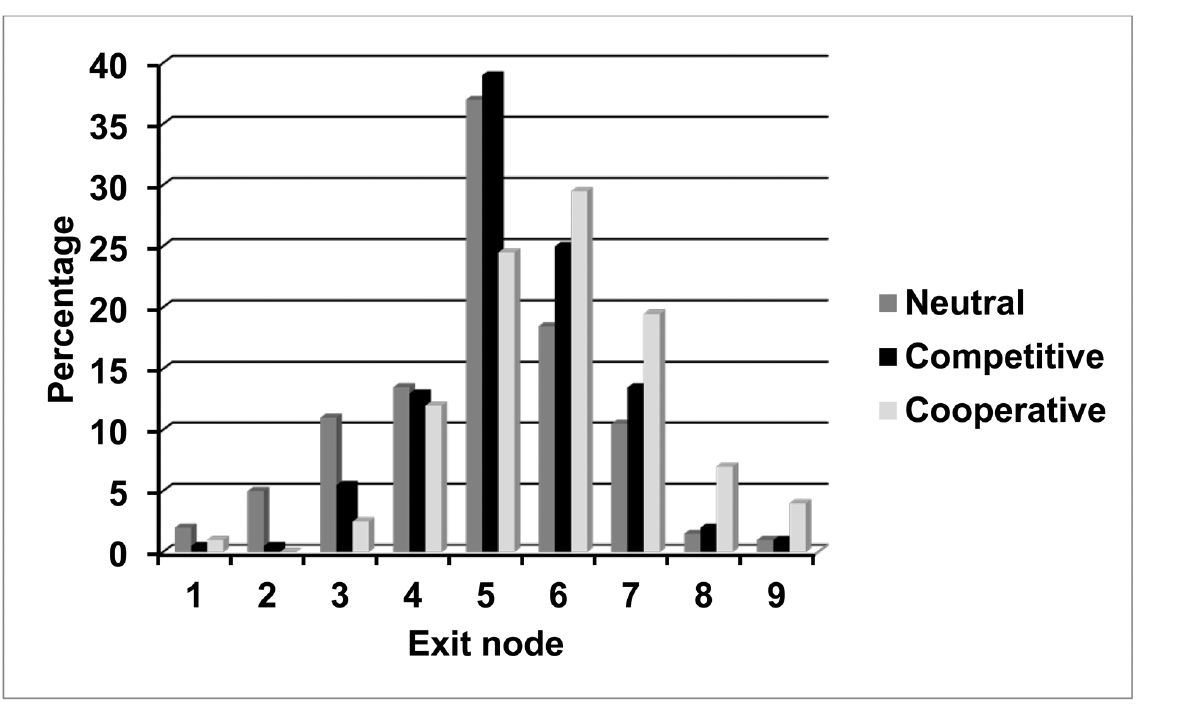
Fig 2. Exit Nodes: Experiment 1. Percentage of games terminating at each exit node in three treatment conditions of Experiment